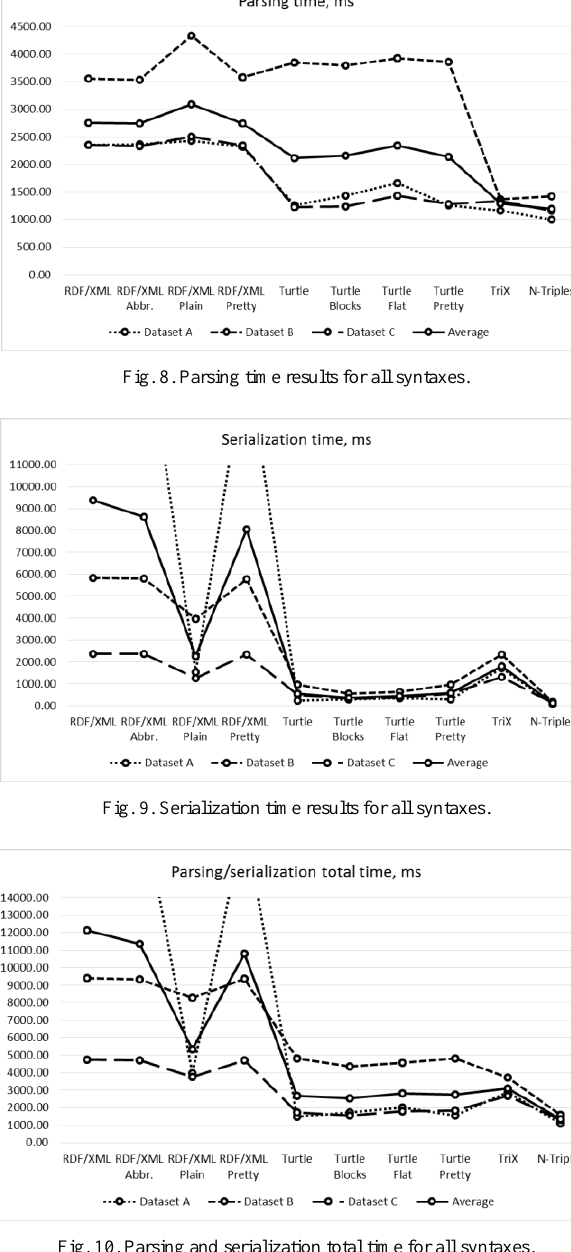
Fig. 10. Parsing and serialization total time for all syntaxes.